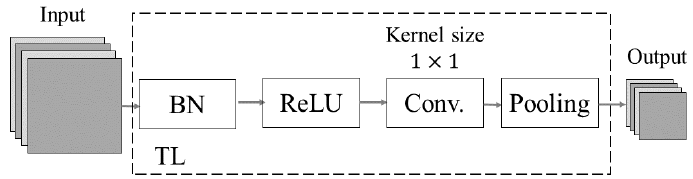
Figure 5. The structure of the transition layer (TL).